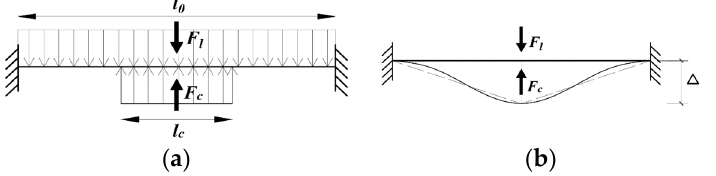
Figure 4. Illustration of the beam model used to mimic the combined effects of corrosion and external load on the epoxy instrumented with a FBG sensor: ( a ) illustration of the beam model and ( b ) illustration of the deformation.